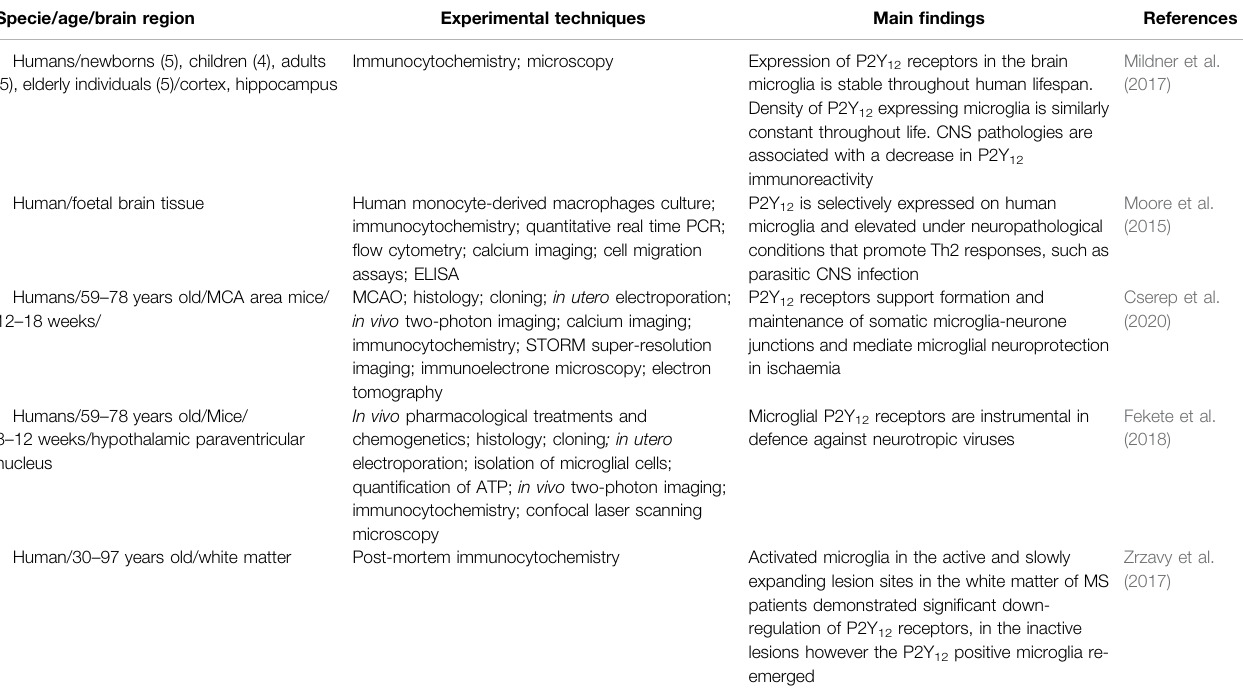
TABLE 1 | ( Continued ) Microglial P2Y 12 receptors in healthy and diseased